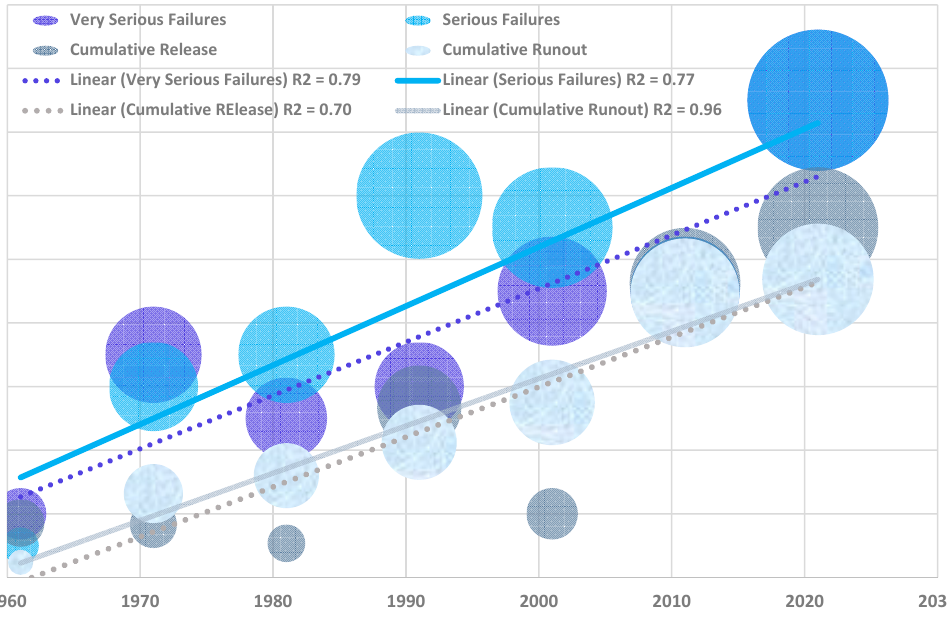
Figure 2. I ncreasing severity & frequency of tailings storage facility failures Figure 2. Increasing severity & frequency of tailings storage facility failures.